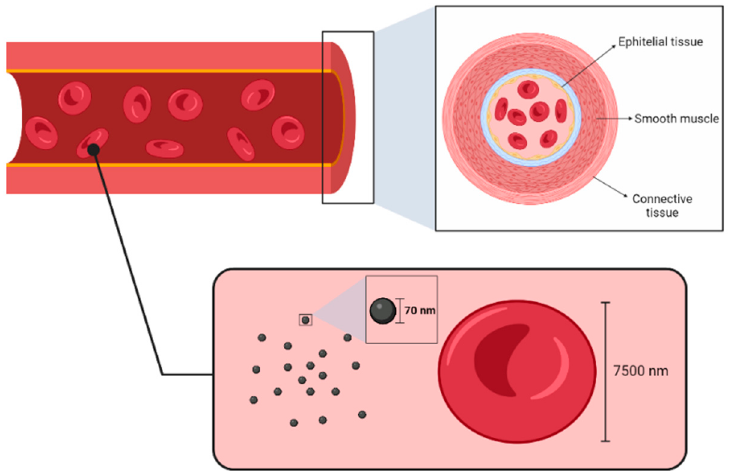
Figure 5. Size comparison of a red blood cell and a 70 nm nanoparticle.